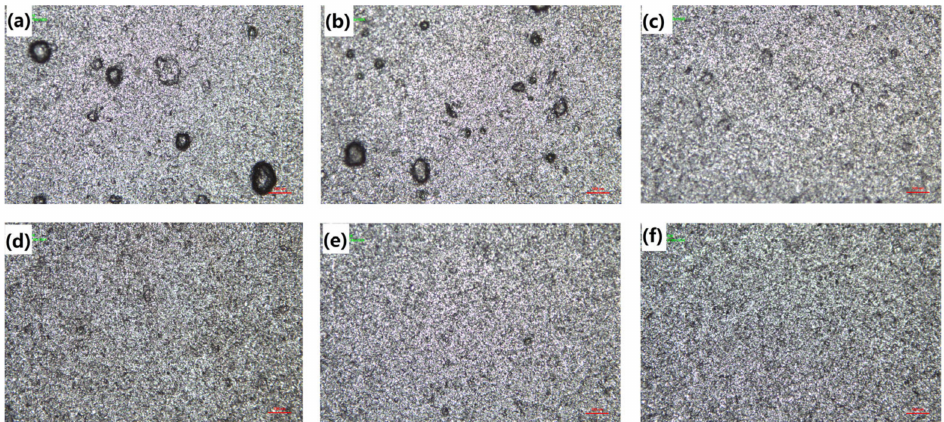
Figure 2. The optical micrograph of nano silver pastes grinded with different roll gaps. ( a ) unground, ( b ) ground with 80 µ m, ( c ) ground with 40 µ m, ( d ) ground with20 µ m, ( e ) ground with 10 µ m, ( f ) ground with 5 µ m.